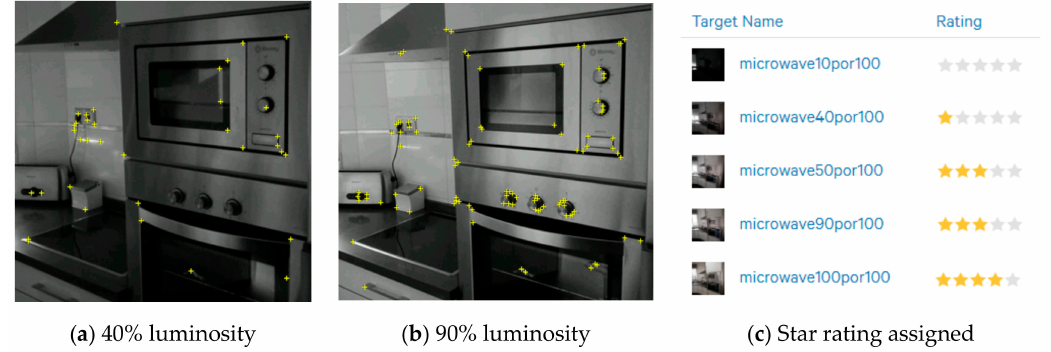
Figure 8. The relation between detected features and light